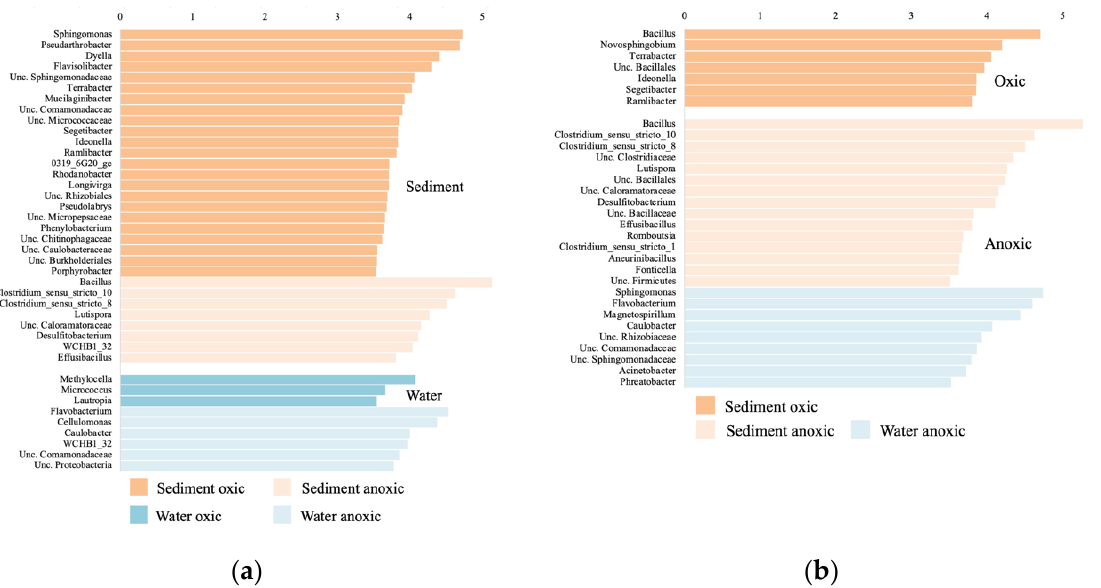
Figure 8. Linear discriminant analysis (LDA) score comparing significantly different bacterial genera between ( a ) the oxic and anoxic samples in the sediment and leachate samples separately; ( b ) the sediment and leachate samples in the oxic and anoxic samples separately; calculated using the lefse analysis. Genera with a LDA score > 3.5 are displayed.